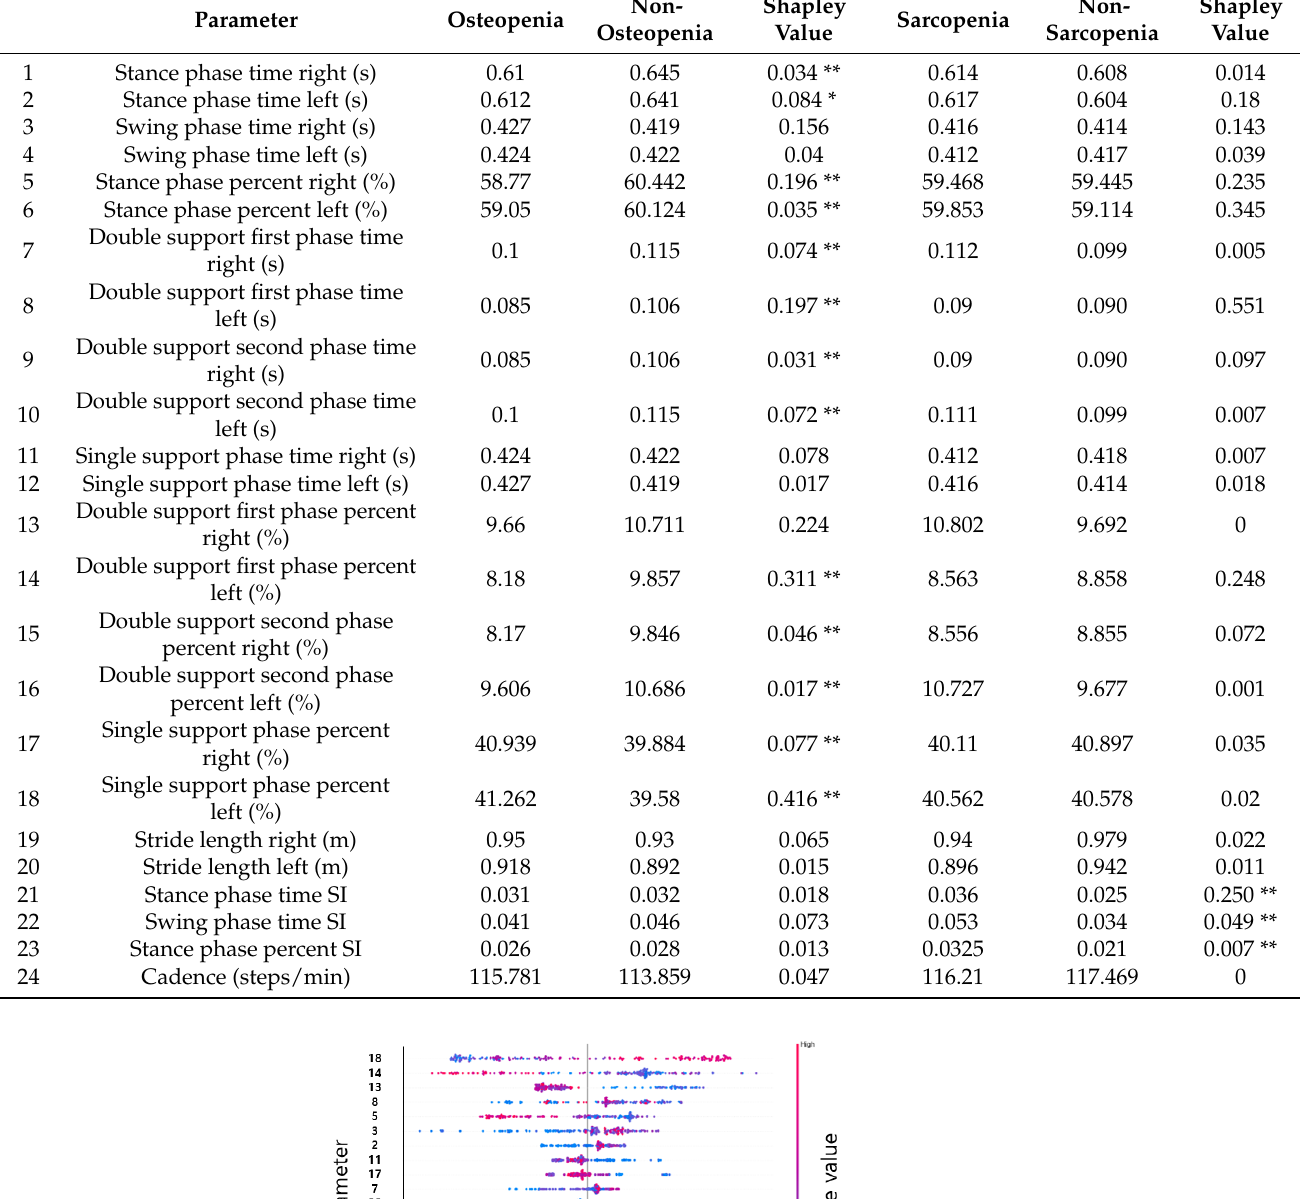
Table 12. Spatial–temporal parameters of osteopenia and